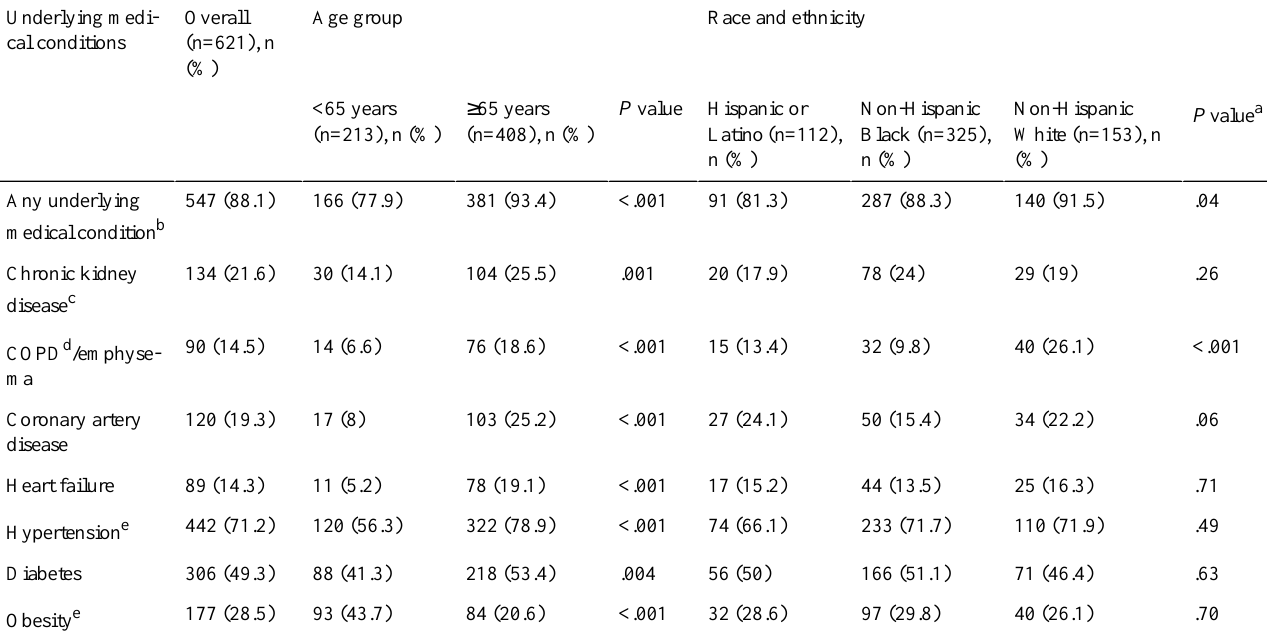
Table 3. Prevalence of underlying medical conditions among US veterans hospitalized with COVID-19—overall, by age, and by race and ethnicity, at 5 Veterans Affairs Medical Centers from February 27 to July 17,